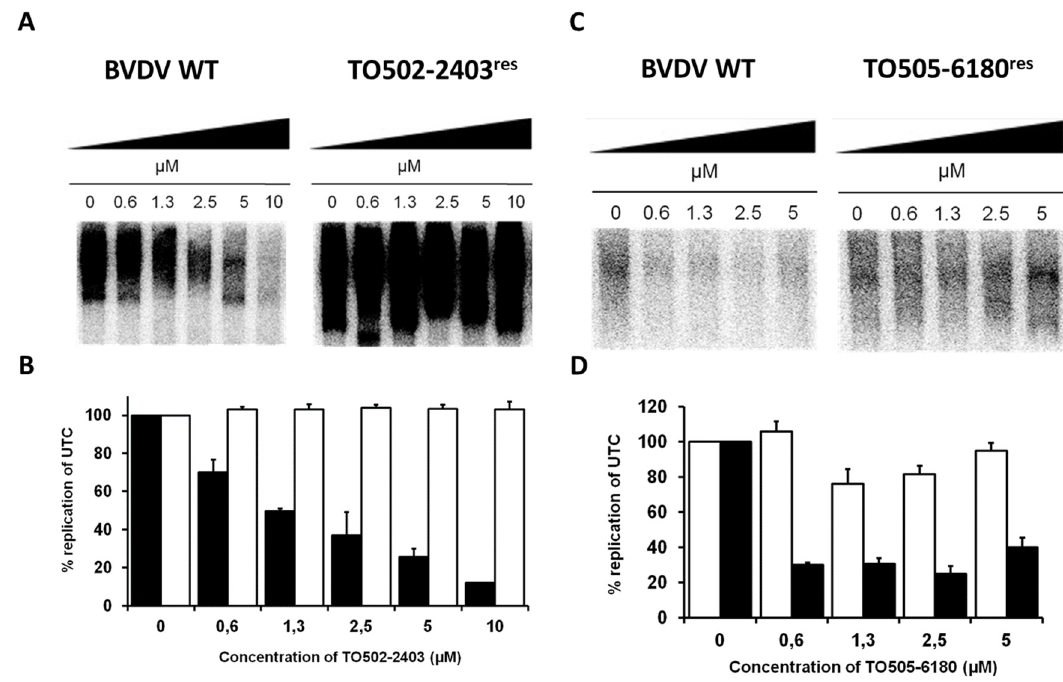
Figure 5. ( A ) Effect of TO502-2403 (CSFCII) on the activity of RCs isolated at 14-h post-infection from MDBK cells that had been infected with wild-type BVDV (NADL) or with the selected TO502-2403 res BVDV strain. Reaction product of the RC assay was separated on a 1% agarose-glyoxal denaturing gel. RCs for these assays were either isolated from the MDBK cells infected with the wild-type virus or with the TO502-2403 res BVDV strain. ( B ) Densiometric analysis of the autoradiograph depicted in panel A and also from a second assay (picture not shown). Black bars represent the activity of the wild-type BVDV (NADL) RCs, and open bars represent the activity of RCs from the cell infected with TO502-2403 res virus. ( C ) Effect of TO505-6180 (CSFCI) on the activity of RCs isolated at 14-h post-infection from the MDBK cells that had been infected with wild-type BVDV (NADL) or with the selected TO505-6180 res BVDV strain. ( D ) Densiometric analysis of the autoradiograph depicted in panel C and also from a second assay (picture not shown). Black bars represent the activity of the wild-type BVDV (NADL) RCs, and open bars represent the activity of the RCs from the cell infected with the TO505-6180 res virus. Data are mean values ± SD of two independent experiments. UTC—untreated control; WT—wild-type.